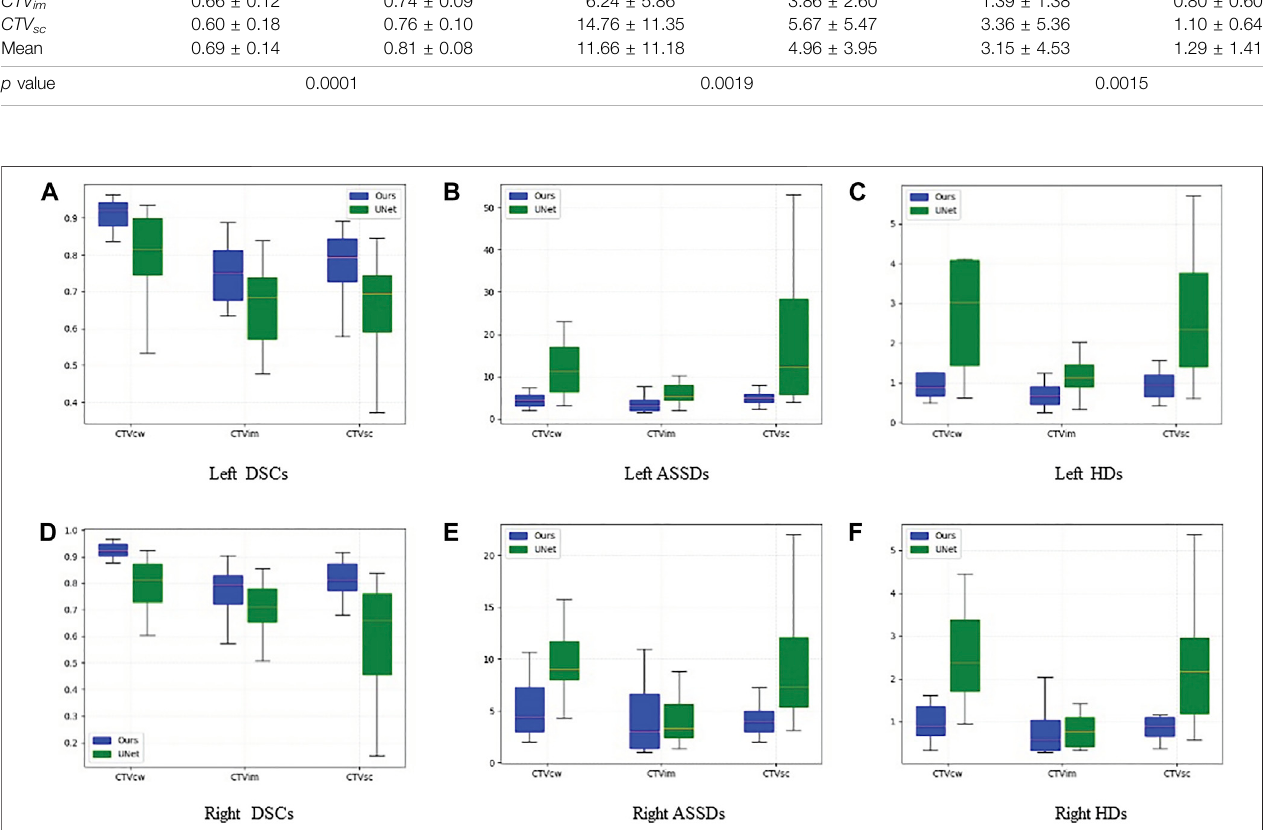
Frontiers in Physics |